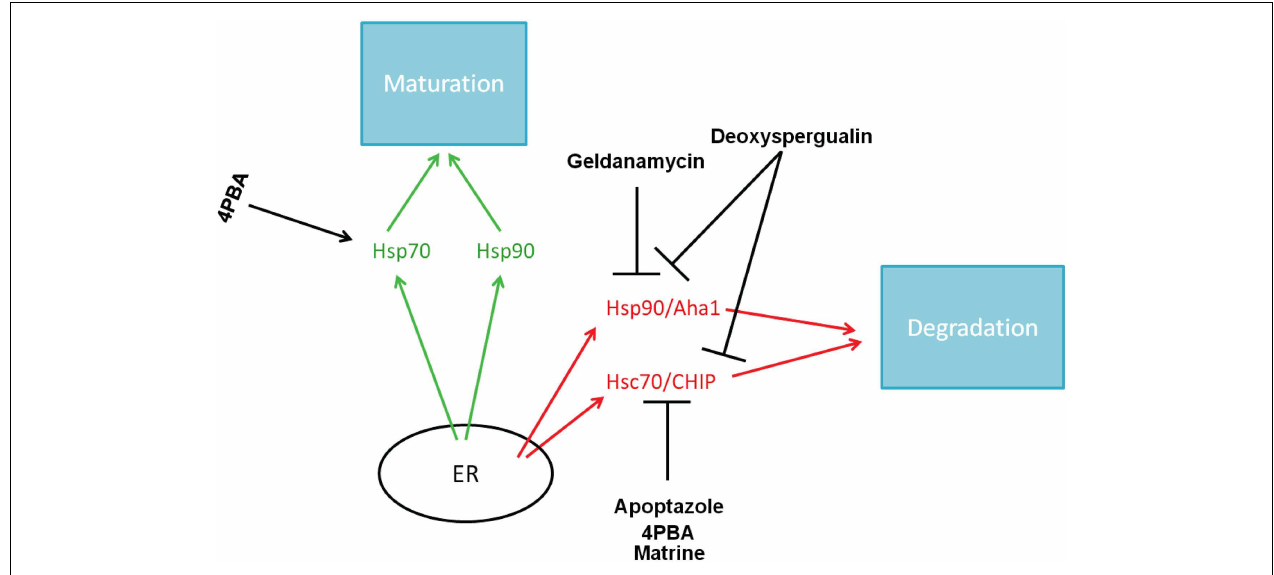
FIGURE 3 |AF508-CFTR correctors and their molecular